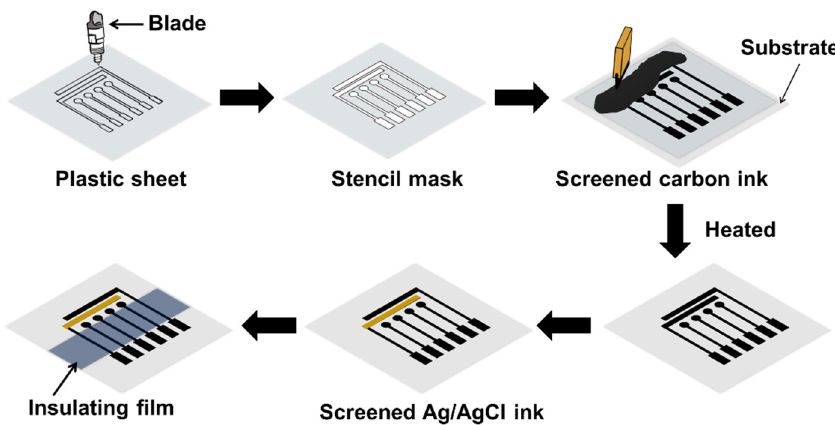
Figure 1. Schematic illustration of the multichannel graphite electrodes fabrication.